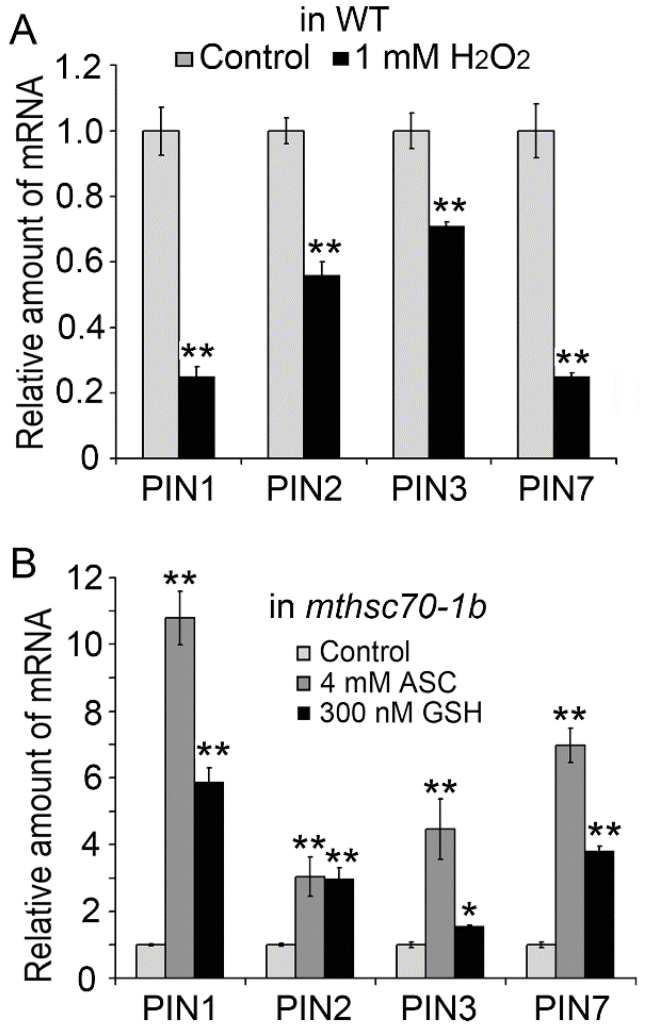
Figure 6. Effects of exogenous redox reagents on the expression of PIN genes in WT and mtHSC70-1 mutant seedlings by Q-PCR. ( A ) The WT seedlings were grown on 0.5 × MS medium with or without 1 mM H 2 O 2 for 10 d. ( B ) The mthsc70-1b seedlings were grown on 0.5 × MS medium with or without 300 nM GSH for 10 d. For the ASC treatment, 10 days old mthsc70-1b seedlings were transferred to liquid 0.5 × MS medium with or without 4 mM ASC for 90 min and then developed for 120 min. The data are the means ± SD of three biological replicates. The asterisks indicate significant differences from the control group ( t -test, *, p < 0.05; **, p < 0.01). WT, wild-type; mthsc70-1b , a mtHSC70-1 mutant line.